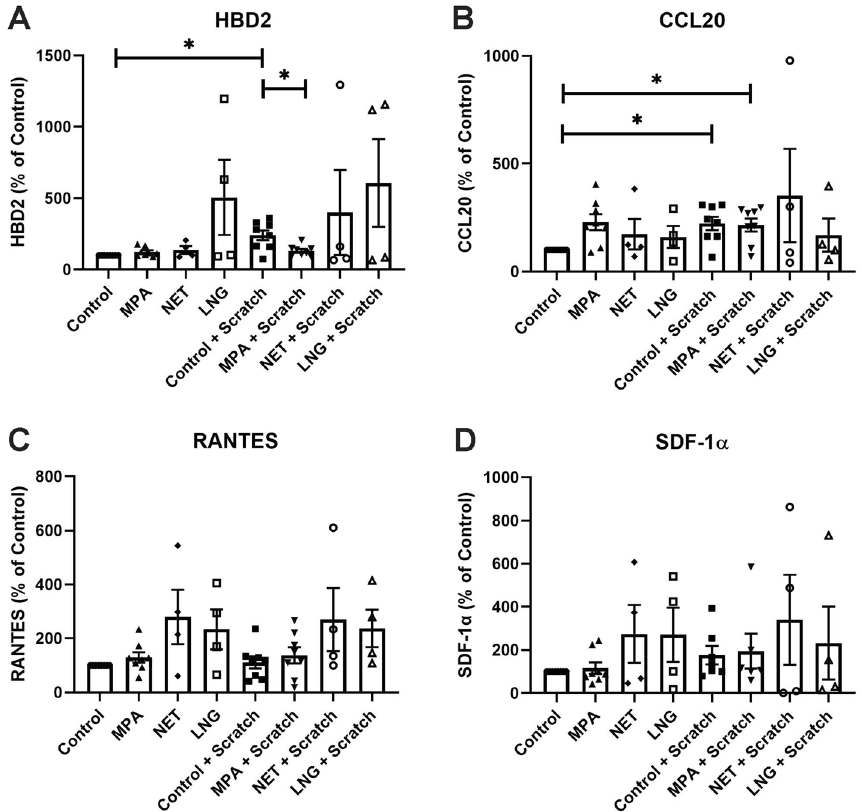
Figure 6. MPA inhibits the upregulation of HBD2 by polarized endometrial epithelial cells following injury. Secretion of (A) HBD2, (B) CCL20, (C) RANTES, and (D) SDF-1α by endometrial epithelial cells grown in transwell inserts 48 h post-scratch. Cells were treated for 48 h with 100 nM MPA, NET, and LNG prior to scratch and maintained in cell culture media following scratch. Bars represent mean + /− SEM. Secretion values were normalized to the control wells which were set to 100. Each symbol represents a single individual (Control n = 8 ; MPA n = 8 ; NET n = 4 ; LNG; n = 4 ). Mean secretion in controls samples: 850 pg/ml (HBD2), 575 pg/ml (CCL20), 37 pg/ml (RANTES), and 59 pg/ml (SDF-1α). Control untreated unscratched control, Control + SC scratched control, MPA unscratched MPA treated, MPA + SC scratched MPA treated, NET unscratched